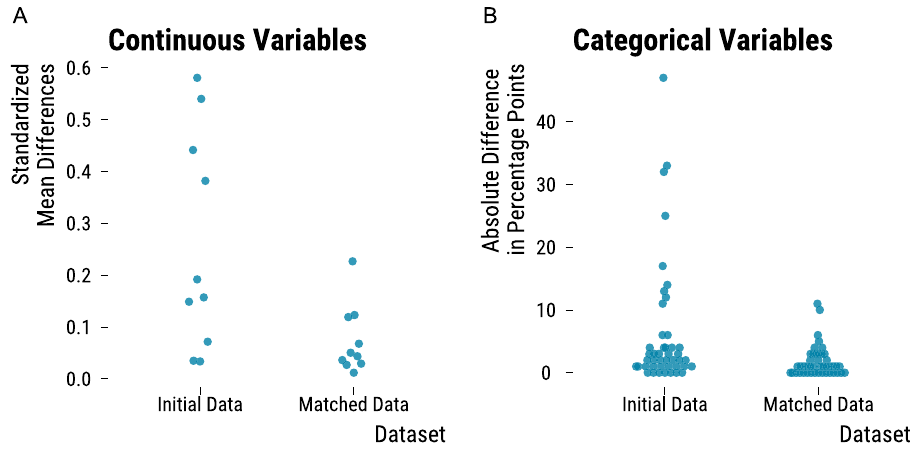
Figure 4. Overall balance improvement in continuous and categorical covariates . In Panel ( A ), we plot, before and after matching, the absolute standardized differences in continuous covariates between treated and control groups. Each blue dot represents an absolute mean difference for a given covariate. In panel ( B ), we plot, before and after matching, the absolute difference in percentage points for categorical covariates.